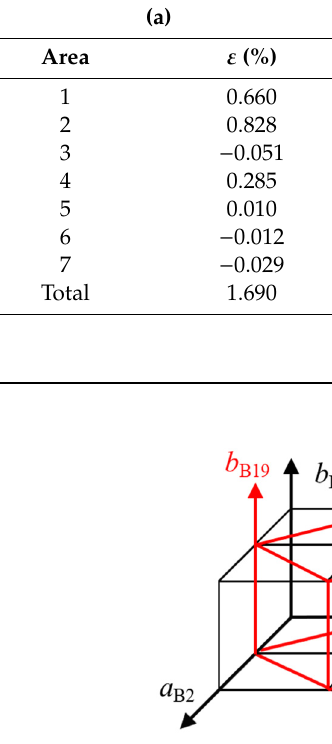
Table 2. Transformation strain calculated by the EBSD results of the isobaric tested equiatomic TiPd alloy. ( a ) Vertical compression direction and ( b ) compression direction.